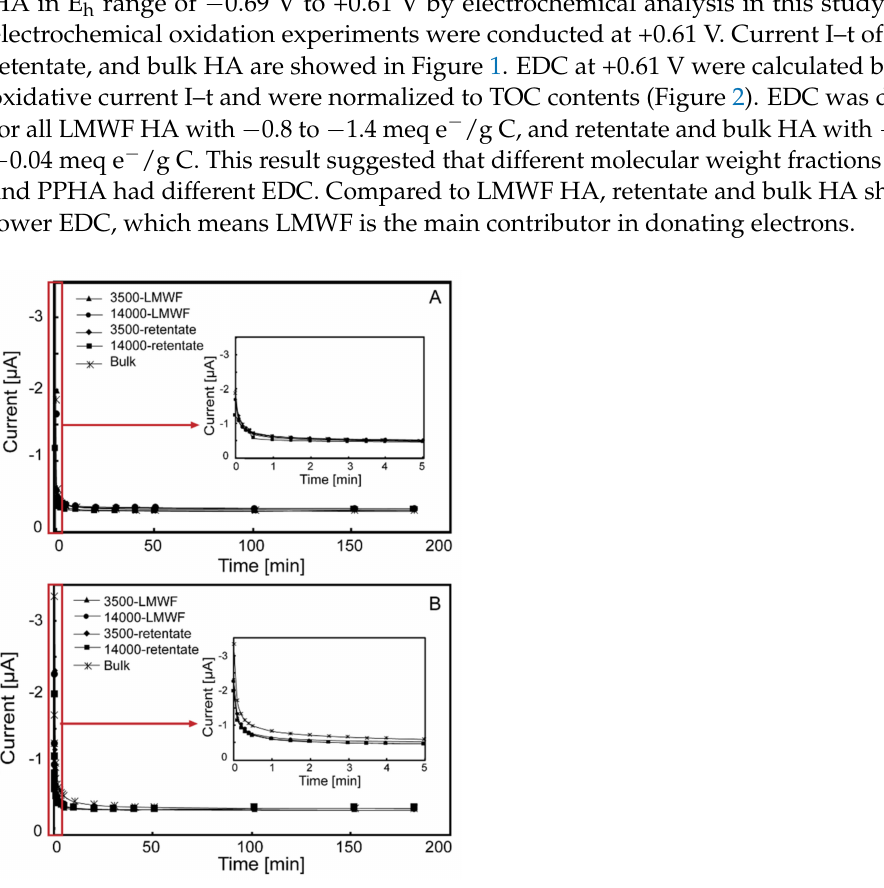
Figure 1. The I–t curve of different molecular weight fractions of HA in direct electrochemical oxidation experiments (The embedded picture is the I–t curve within 3 min of reaction.) ( A ) LHA; ( B )